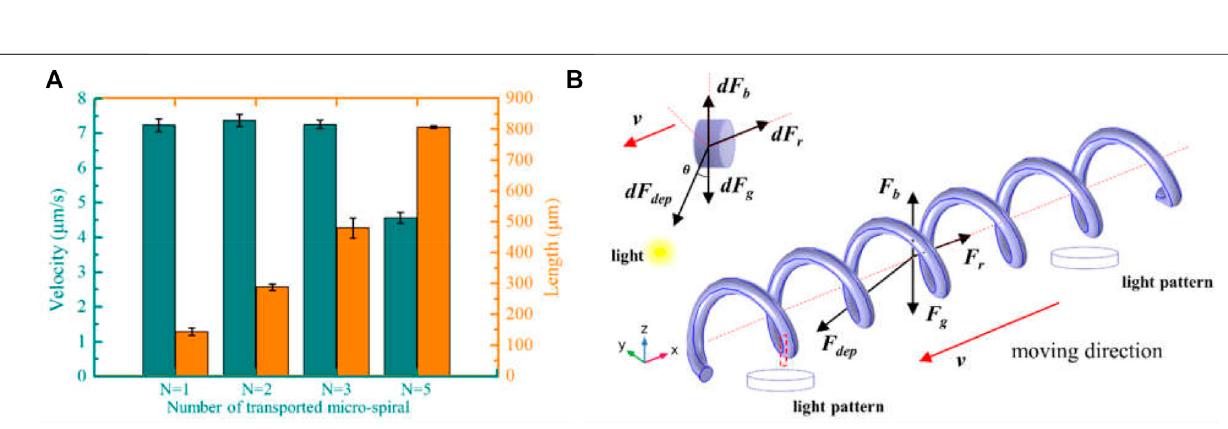
Frontiers in Bioengineering and Biotechnology |